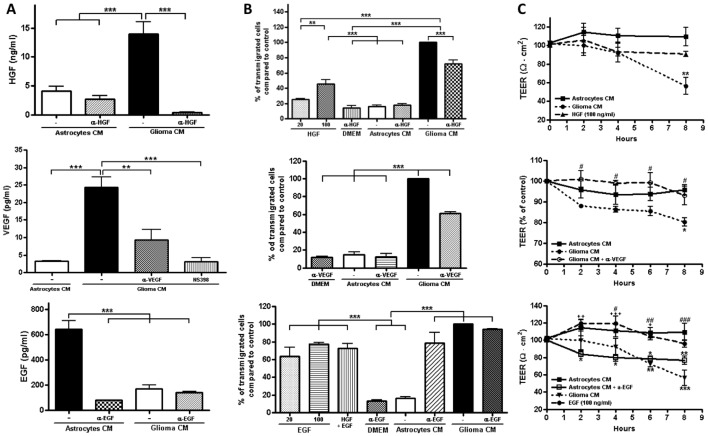
HGF, VEGF and the lack of EGF in glioma C6 CM induce NSCs transmigration across
RBMECs.A) The amount of HGF and VEGF determined by ELISA is higher in glioma C6 CM than in astrocyte CM,
while the opposite is found for EGF. IP of HGF, VEGF or EGF reduces the amount of the growth factor
present in CM. HGF: N = 4, F(3,12) = 26.54; VEGF: N = 3, F(3,8) = 20.98; EGF: N = 3, F(3,8) = 44.52;
**P<0.01, ***P<0.001, ns = not significant; as assessed by one-way ANOVA followed by
Bonferroni's post hoc test. B) ReNcells CX transmigration assay across RBMECs done by placing in the
basal compartment of the Millicell, DMEM with HGF or EGF; or DMEM with neutralizing antibodies
against HGF, VEGF or EGF; or astrocyte or glioma C6 CM with or without neutralizing antibodies
against HGF, VEGF and EGF. Control corresponds to the transmigration induced by glioma C6 CM without
the neutralizing antibodies against HGF (upper panel), VEGF (middle panel) and EGF (lower panel),
and is considered as 100% transmigration. HGF: N = 3, F(6,14) = 124.7; VEGF: N = 3, F(4,10) = 275.5;
EGF: N = 3, F(7,16) = 30.77; **P<0.01, ***P<0.001, ns = not significant; as assessed by
one-way ANOVA followed by Bonferroni's post hoc test. C) RBMECs cultured for 8 h in DMEM with HGF
and EGF have a TEER similar to that obtained with astrocyte CM. IP of VEGF reverses the decrease in
TEER induced by glioma C6 CM whereas IP of EGF from astrocyte CM decreases TEER in a manner similar
to that obtained with glioma C6 CM. HGF: N = 3, F(2,16) = 5.668; **P<0.01 with respect to
astrocytes CM; VEGF: N = 3, F(2,20) = 14.64; *P<0.05 with respect to astrocytes CM; #P<0.05
with respect to glioma C6 CM; EGF: N = 3, F(3,30) = 23.07; *P<0.05, **P<0.01, ***P<0.001
with respect to astrocytes CM; #P<0.05, ##P<0.01,
###P<0.001 with respect to glioma C6 CM; +P<0.05,
++P<0.01, +++P<0.001 with respect to astrocytes CM + α-EGF; as assessed
by one-way ANOVA followed by Bonferroni's post hoc test.